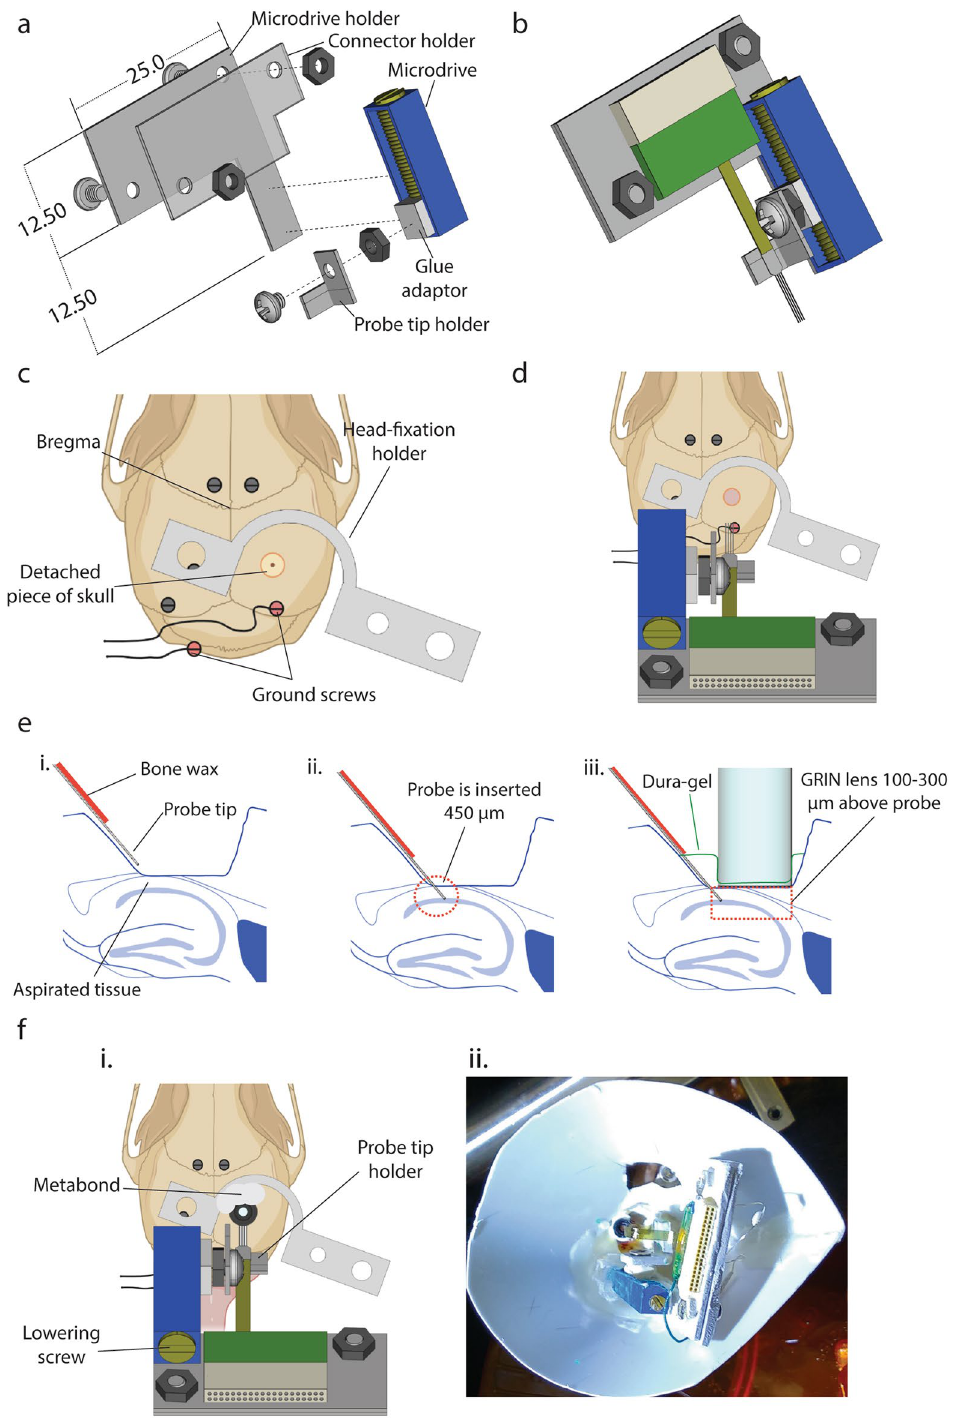
Figure 5. Microdrive assembly and its implantation together with a GRIN lens, used for Fig. 6. ( a ) Parts of a microdrive assembly. Dimensions are described in mm. ( b ) Completed microdrive assembly. ( c ) Positioning of screws, ground screws and head-fixation holder on the mouse skull. ( d ) Positioning of the microdrive assembly on the skull before inserting the tip of silicon probe into brain tissue. ( e ) Schematic showing implantation procedure from the sagittal view of the hippocampus. i. The silicon probe is lowered into the aspirated space under the skull. ii. The silicon probe is lowered 450 µm into the brain. iii. A GRIN lens is lowered closed to the aspirated surface of brain tissue and placed as closely as possible to the probe tip. We covered exposed surfaces of the aspirated brain tissue with Dura-gel. ( f ) i. Final position of the microdrive-lens assembly on the mouse skull. ii. A custom-made cover protecting the microdrive-lens assembly on the mouse